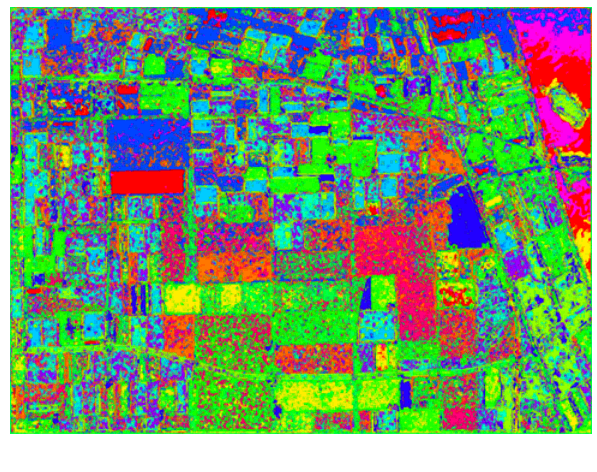
Figure 27. Classification Map of our